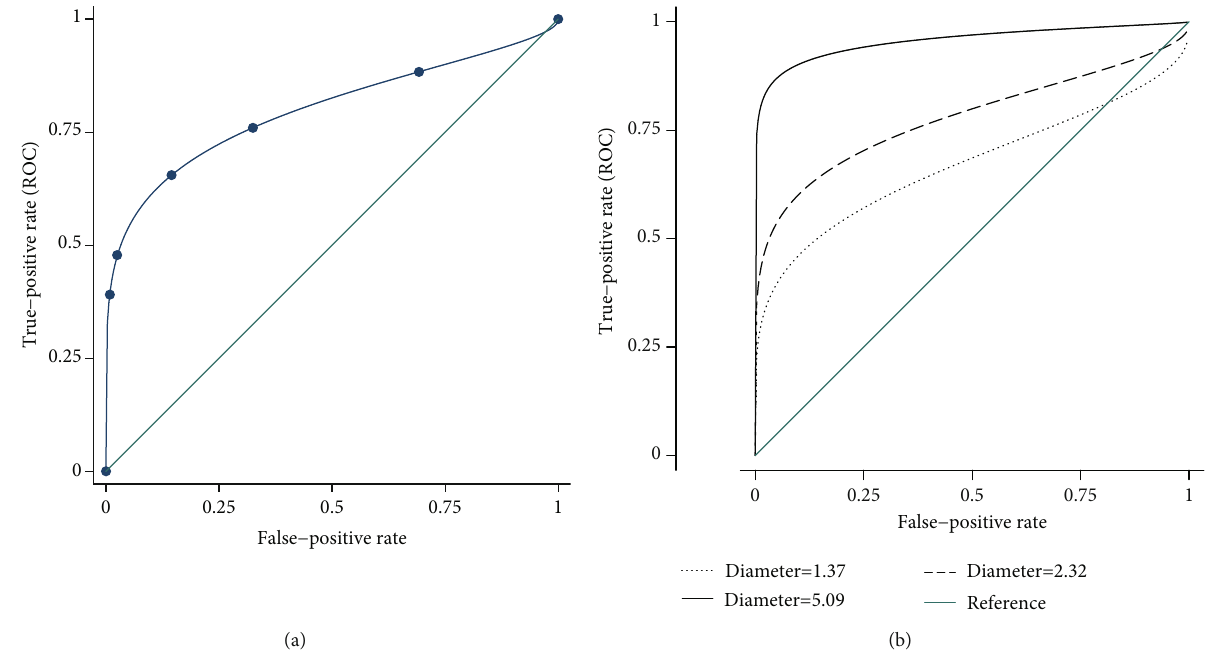
Figure 4: (a) Overall ROC curve derived from the combined assessment of all 7 readers ( AUC = 0 : 80 ). (b) Expected ROC curves for 3 di ff erent tumor sizes ( AUC = 0 : 67 , 0.78, and 0.96). Table 1: Reader study ROC area under the curve values. Quartile